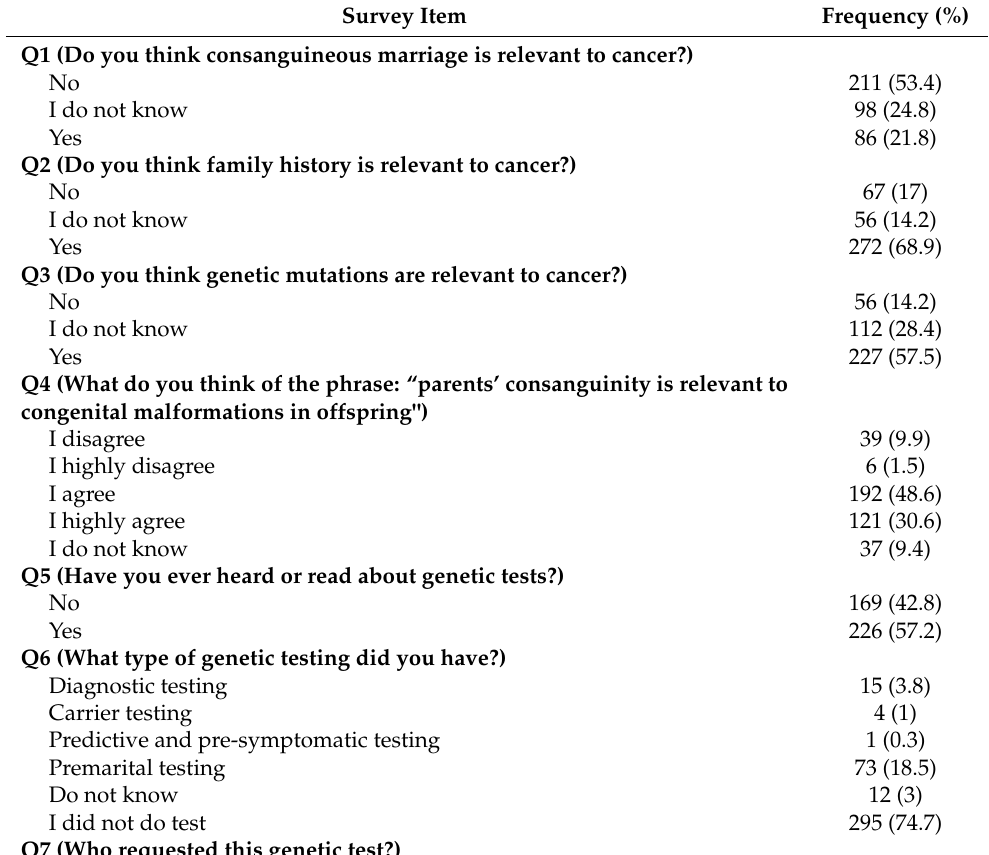
Table 2. Awareness, perceptions, and attitudes towards familial and inherited cancer (n = 395). Survey